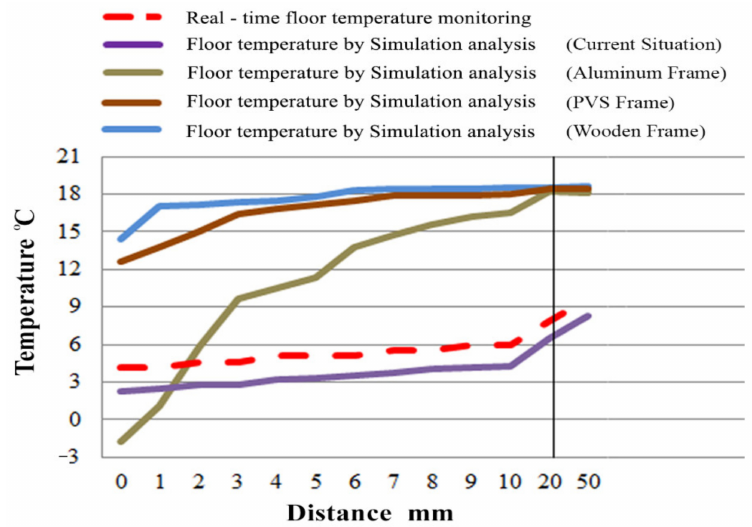
Figure 14. Floor temperatures for the first 50 mm using thermal break 20